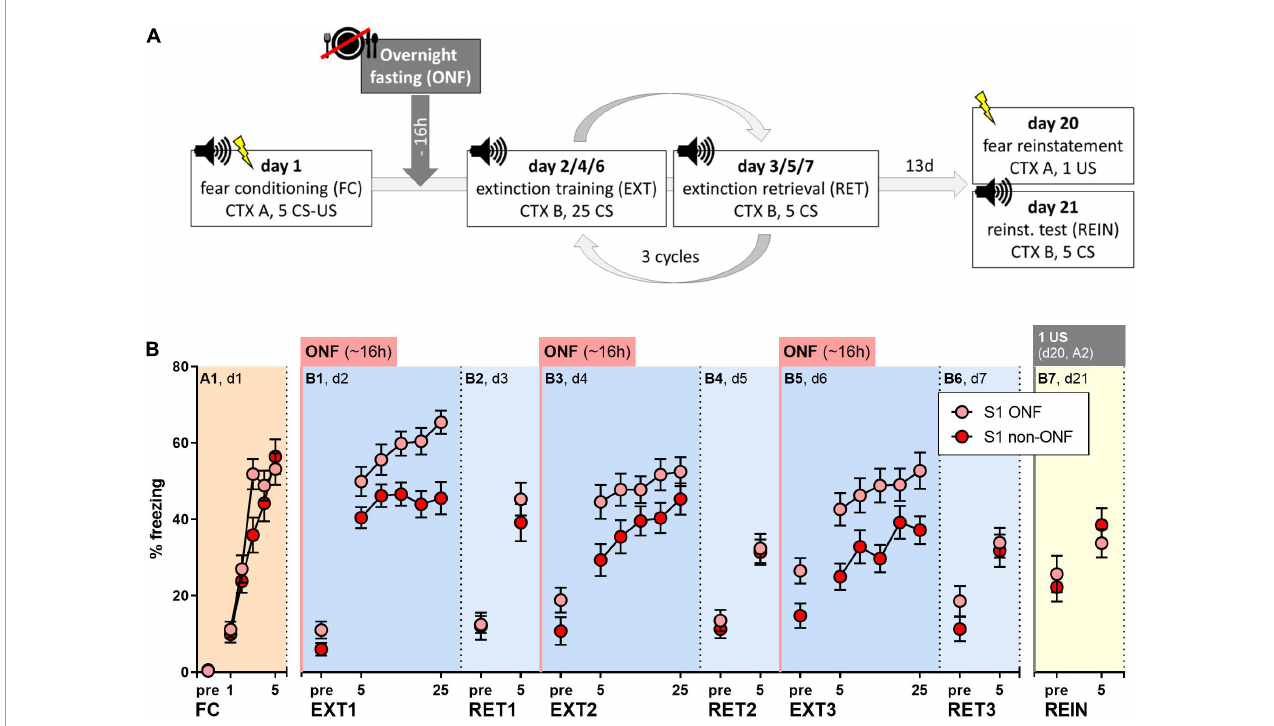
FIGURE4 Effect of pre-extinction training overnight fasting on fear extinction in 129S1/SvImJ (S1) mice. (A) Experimental protocol and conditions for all behavioral tests. (B) Percent of time spent freezing during pre-CS periods or indicated CS presentations throughout the experimental paradigm. Both groups showed sufficient fear acquisition [FC/A1: “CS block” p < 0.0001, F (3.542, 159.4) = 56.56]. Overnight fasting before fear extinction increased freezing levels compared to non-fasted controls [“treatment” for EXT1/B1; EXT2/B3; EXT3/B5: p = 0.0011, F (1, 45) = 12.11; p = 0.0346, F (1, 45) = 4.749, p = 0.0052, F (1, 45) = 8.618], while there were no significant differences during extinction retrieval or fear reinstatement tests when all mice were fed (RET1/B2, RET2/B4, RET3/B6, REIN/B7). Figure info: S1 ONF (pink): n = 23; S1 non-ONF (red): n = 24. All data points represent group means ± SEM for the indicated time periods (pre-CS, single CS or 5-CS average blocks). ONF, overnight fasted; FC, fear conditioning; EXT, extinction training; RET, extinction retrieval; REIN, fear reinstatement test; US, unconditioned stimulus; CS, conditioned stimulus; pre, pre-CS